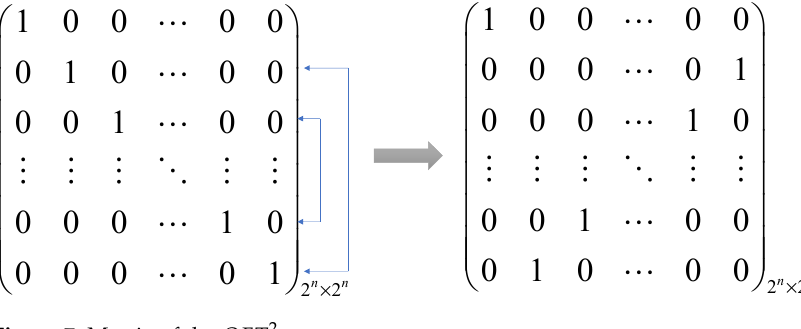
Figure 7. Matrix of the QFT 2 . Therefore, the quantum circuit of Figure 6 can be simplified as Figure 8.